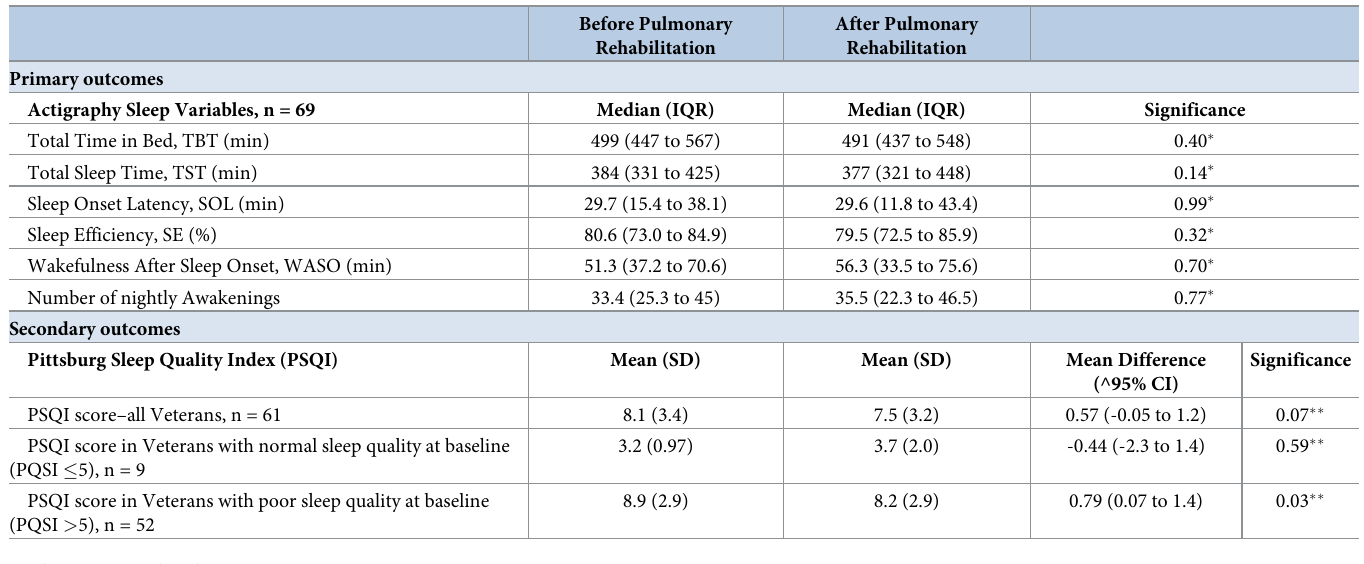
Before Pulmonary After Pulmonary Rehabilitation Rehabilitation